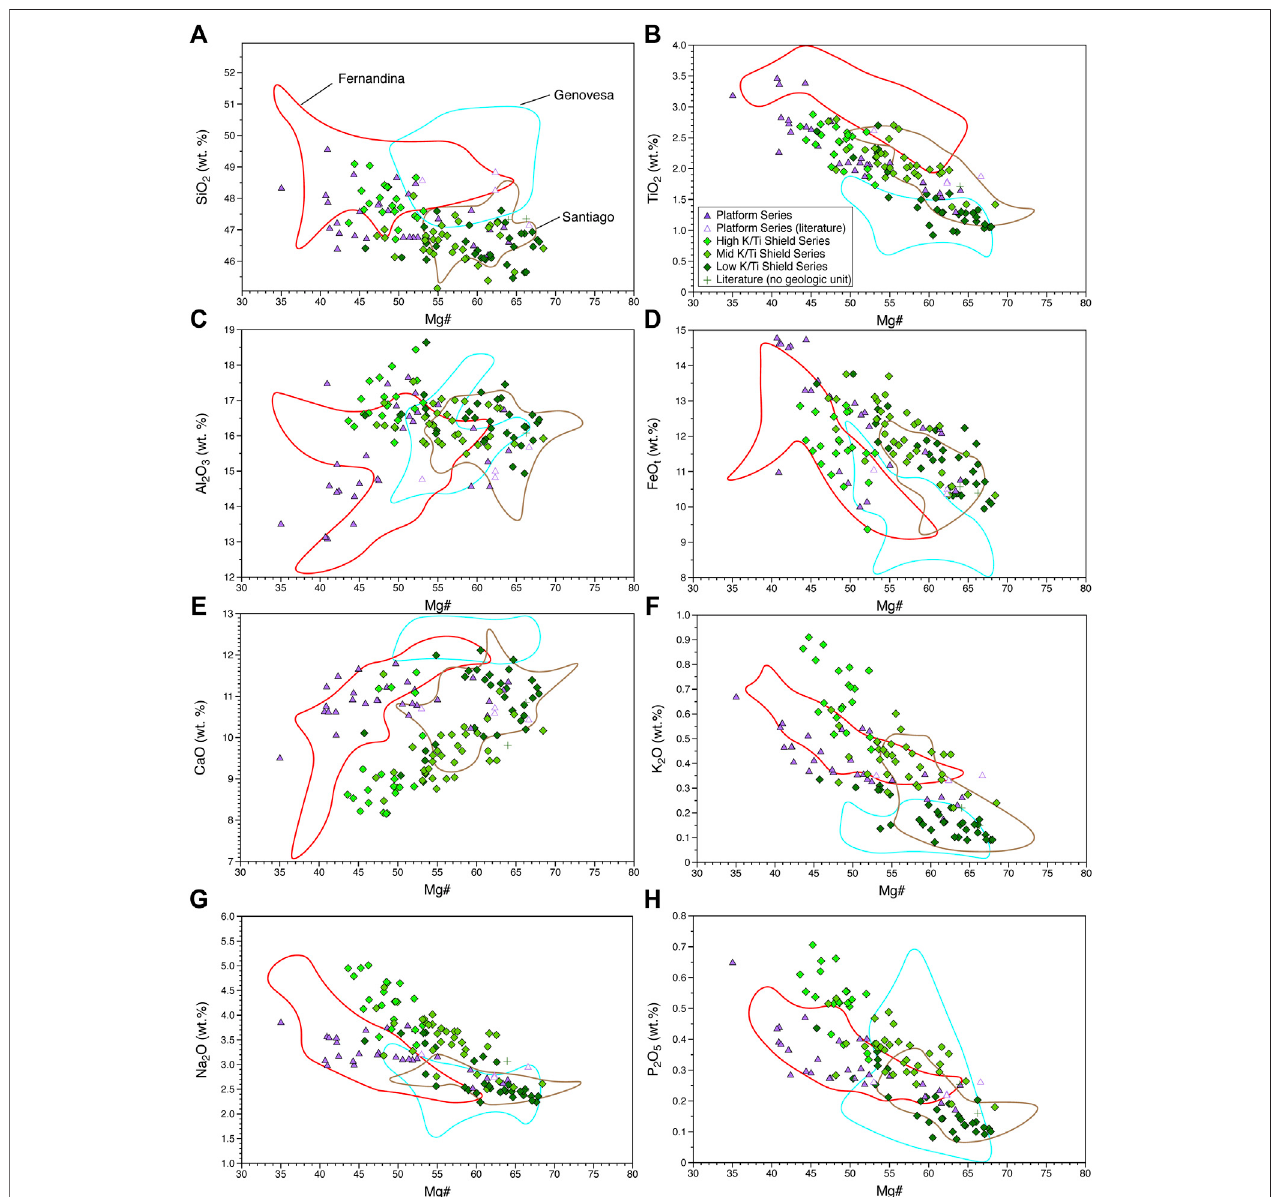
FIGURE3| SelectedmajorelementvariationversusMg#forSantaCruzlavas.Fieldsareliteraturedata.Red:Fernandina, blue:Genovesa,brown:Santiago(White et al., 1993; Harpp et al., 2002; Harpp et al., 2003; Saal et al., 2007; Gibson and Geist, 2010; Gibson et al., 2012; Harpp et al., 2014a). Concentrations are in weight percent (wt.%) and have been normalized to 100%. Mg# = [molar Mg/(Mg + Fe)]. Symbols are larger than 1 σ analytical error. Samples indicated by a cross are literature datafromSantaCruz(Whiteetal.,1993;KurzandGeist,1999;Saaletal.,2007);theyhavenotbeenattributedtoeitherthePlatformorShieldSeriesowingtoalack of GPS coordinates for their origin locations. (A) SiO 2 -Mg#; (B) TiO 2 -Mg#; (C) Al 2 O 3 -Mg#; (D) FeOtotal-Mg#; (E) CaO-Mg#; (F) K 2 O-Mg#; (G) Na 2 O-Mg#; (H) P 2 O 5